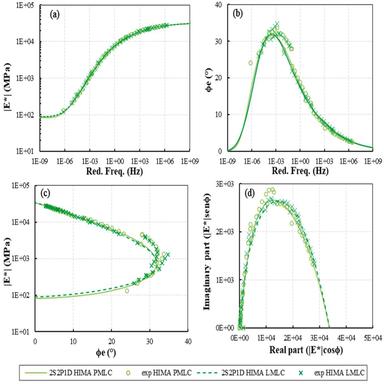
Stiffness of the "HIMA" asphalt mixture with LMLC and PMLC samples: (a) dynamic modulus master curve; (b) phase angle master curve; (c) Black space; (d) Cole-Cole.